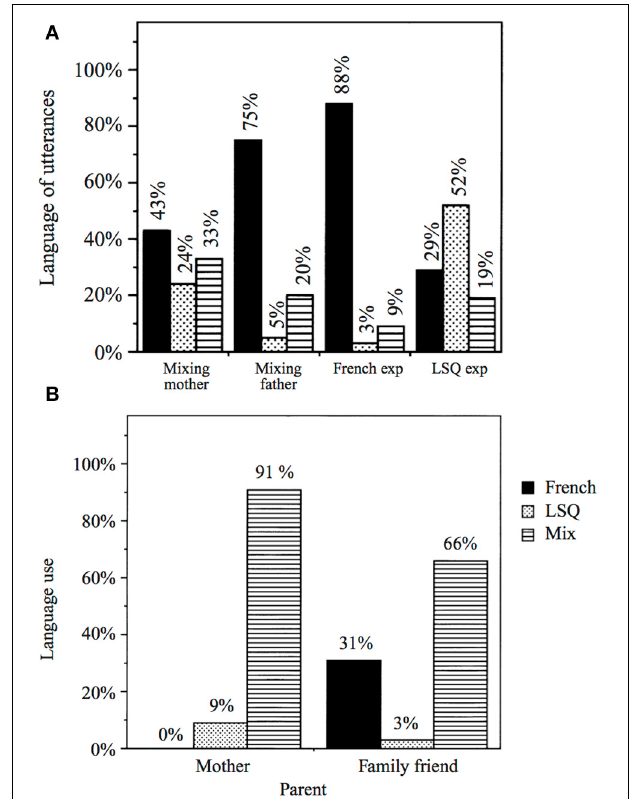
FIGURE 4 | Bimodal bilinguals. Language choice by (A) one hearing bimodal bilingual child and (B) her interlocutors (Petitto et al., 2001) (Reproduced with permission from Cambridge University